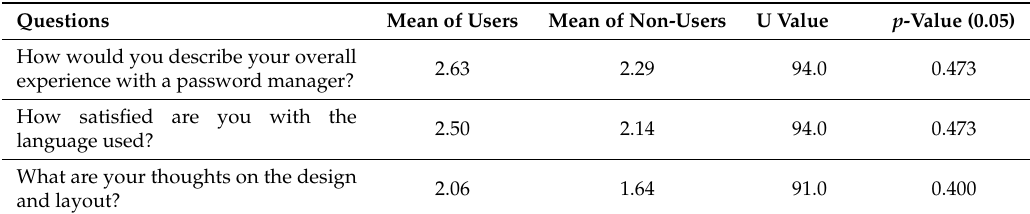
Table 10. The mean, Mann Whitney U value and p -value of each question for 16 users and 14 non-users (satisfaction). Exact significance is displayed for this test [2*(1-tailed